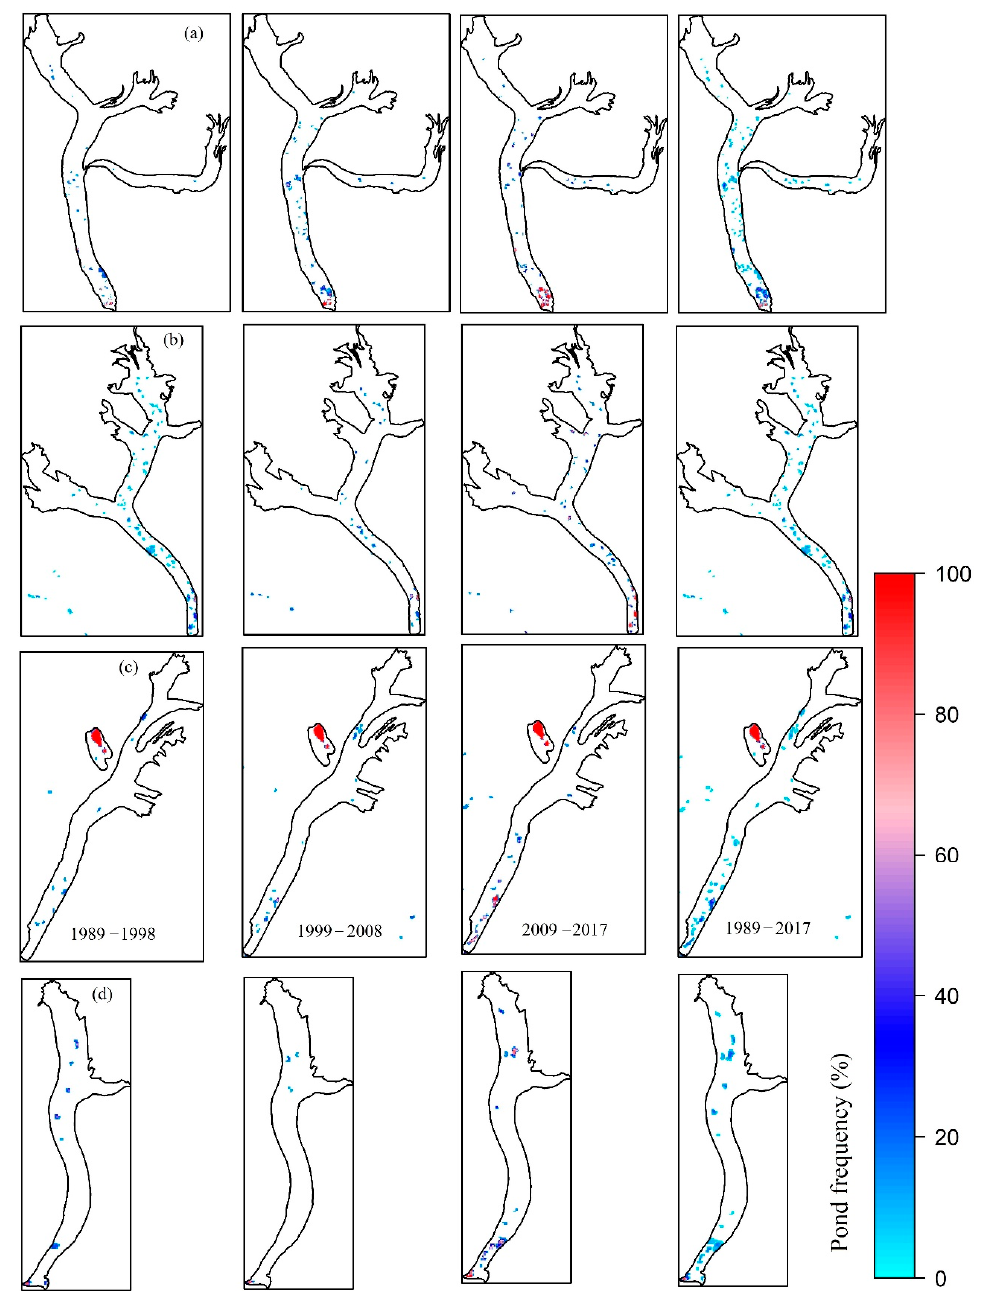
Figure 7. Distribution of supraglacial ponds in (a) Ngozompa, (b) Khumbu, (c) Bhote Koshi, and (d) Lumsamba glaciers in different time periods from 1989 and 2017, highlighting the persistence of individual ponds. The pond persistency of the remainder of the glaciers is provided in the supplementary file (Figure S7).